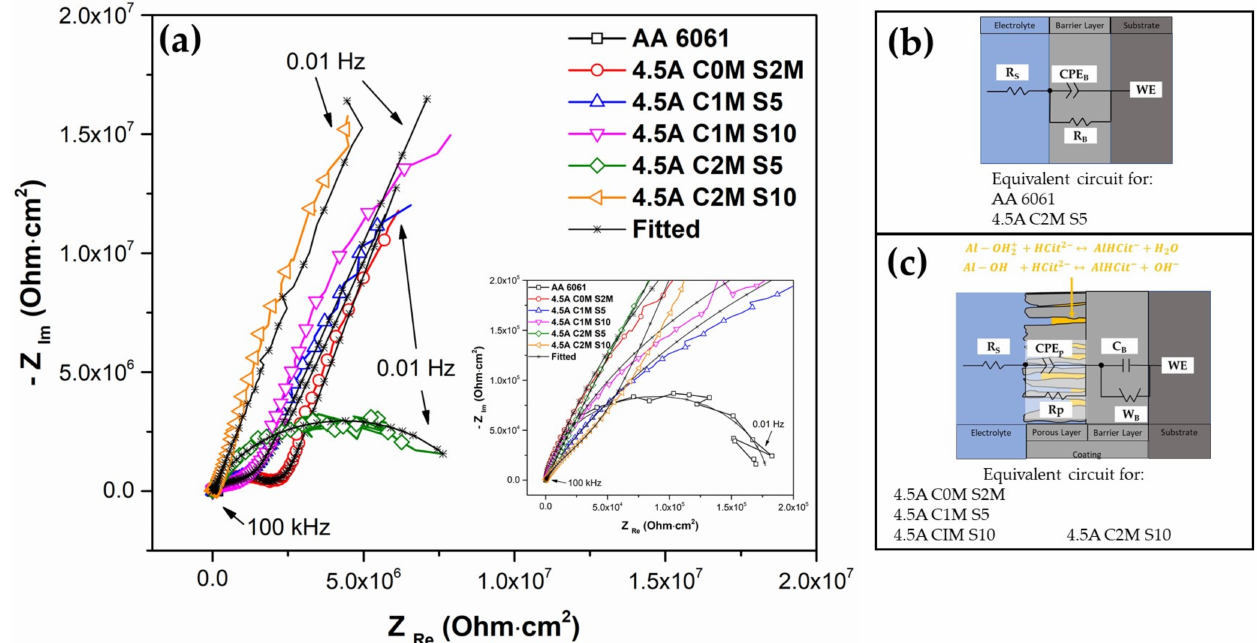
Figure 10. ( a ) Nyquist Diagrams to Non-Anodized and Anodized Samples a 4.5 A/dm 2 in NaCl Solution, ( b , c ) Equivalent